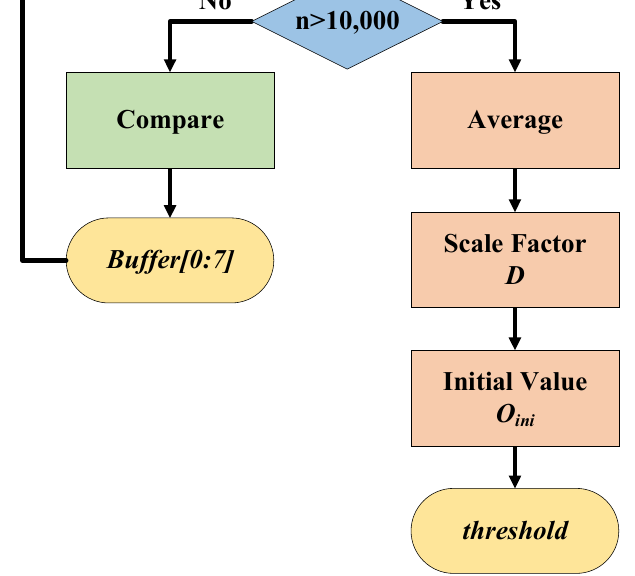
Figure 4. ACD system flowchart. Figure 5 is the average slope maximum So and Chan (ASM S & C) system flowchart.